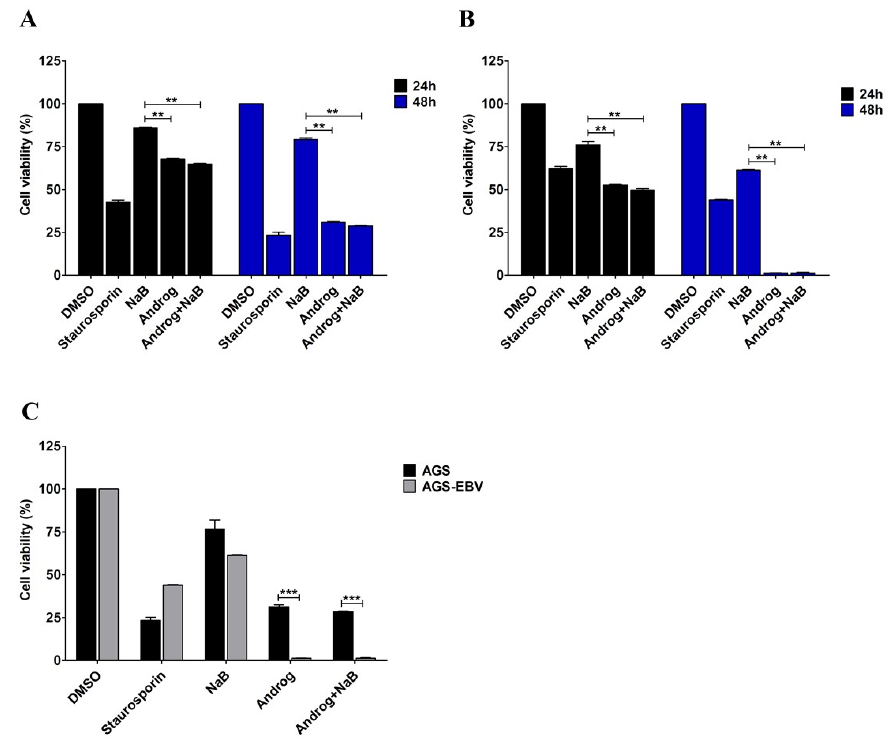
Figure 6. Andrographolide induces cytotoxicity in the EBVaGC cell line. AGS and AGS-EBV cells were either treated with NaB or andrographolide or a combination of both for 24 and 48 h. Viability of AGS cells ( A ) and of AGS-EBV cells ( B ) was evaluated using the CCK-8 assay. ( C ) The comparison of viability of AGS and AGS-EBV cells after treatment with NaB or andrographolide or the combination of both for 48 h. Staurosporin was used as a positive control for cell cytotoxicity. **: p < 0.01 and ***: p < 0.001.